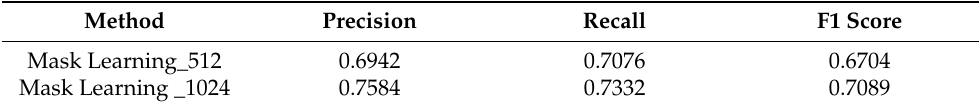
Figure 6. Road Extraction Results Using Mask Learning Only. Table 1. The performance evaluation of road extraction using mask learning